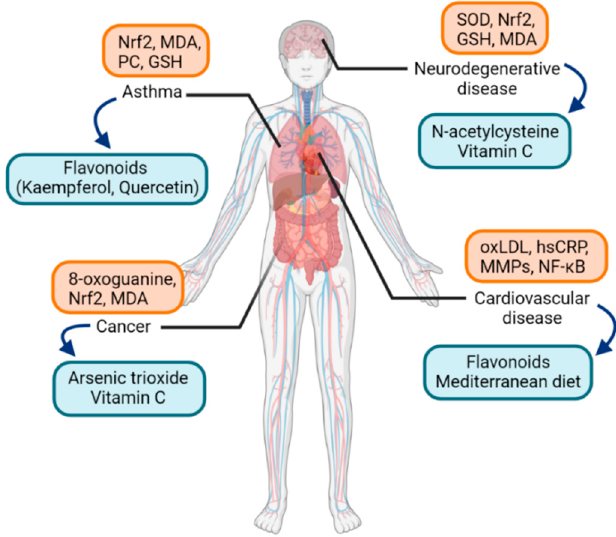
Figure 2. Examples of oxidative ‐ stress ‐ related diseases and associated oxidative stress markers (or ‐ ange box) along with possible therapeutic antioxidants (blue box). Abbreviations: Nrf2, nuclear fac ‐ tor erythroid 2 ‐ related factor 2; MDA, malondialdehyde; PC, protein carbonyl; GSH, glutathione;